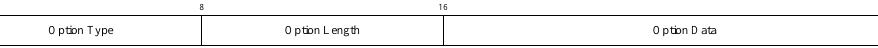
Figure 12. ICMPv6 SCHC fragmentation context